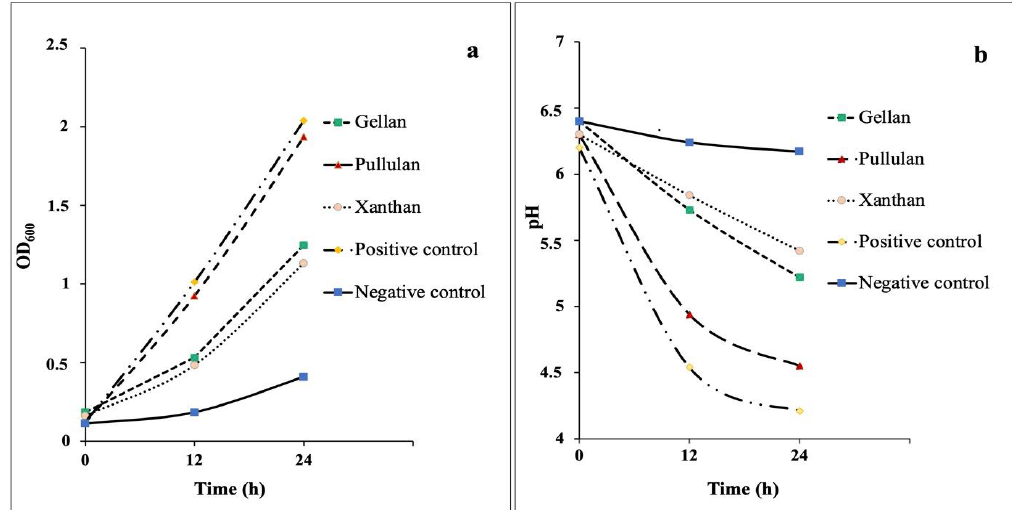
Figure 1. Effects of the media with different added carbon sources on L. rhamnosus GG growth ( a ) and the corresponding pH values ( b ).